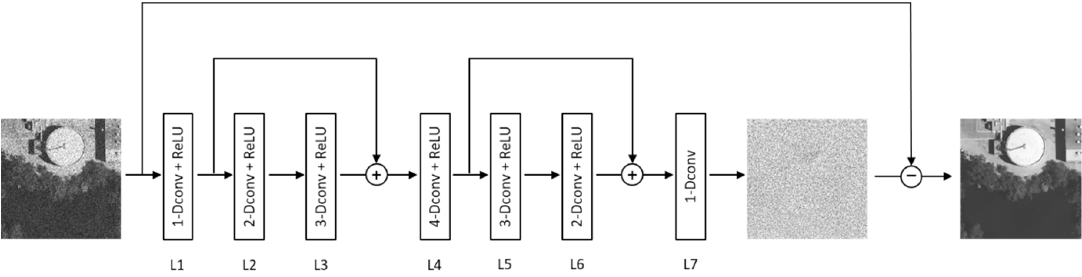
Figure 1. The architecture of the proposed SAR-DRN.